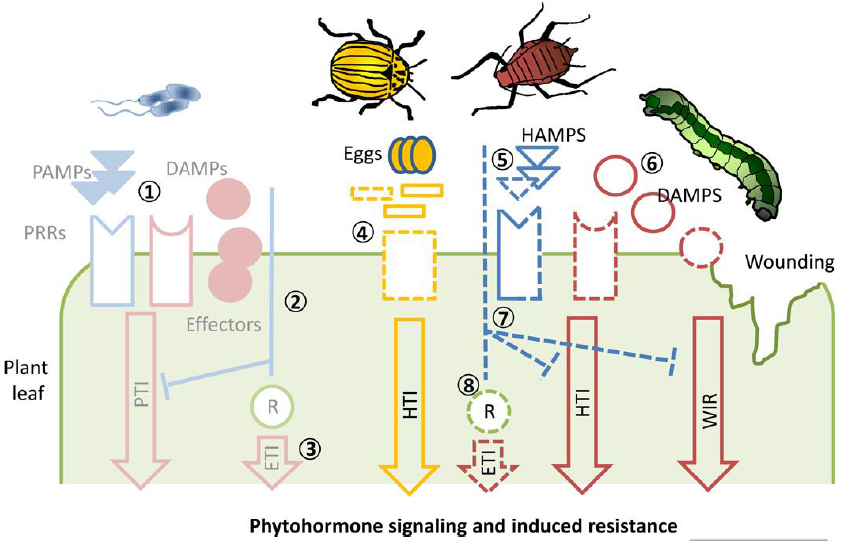
Figure 2. Recognition mechanisms of biotic stresses due to phytopathogens and pests. Reprinted from [30], Copyright (2012), with permission from Elsevier. MAMPs, PAMPs, DAMPs, and HAMPS refer to microbe-, pathogen-, damage-, and herbivore-associated molecular patterns, respectively; PRRs are pattern recognition receptors; PTI/ETI and HTI refer to PAMP/effector- and herbivore- triggered immunity, respectively; WIR refers to wound-induced resistance; uncharacterized elements are indicated by broken